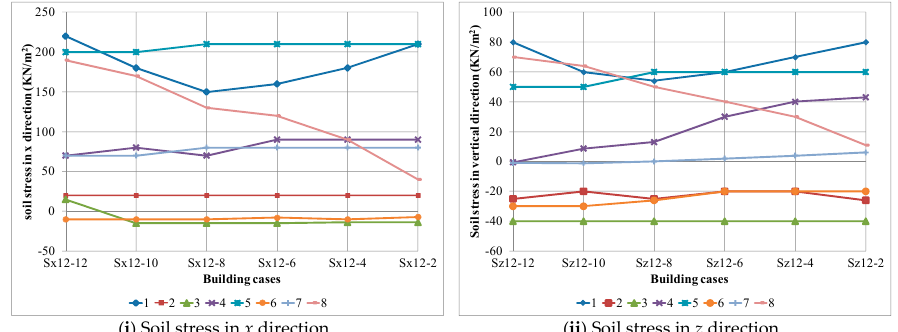
Figure 17. Stresses in the soil around the foundation of the two adjacent buildings.